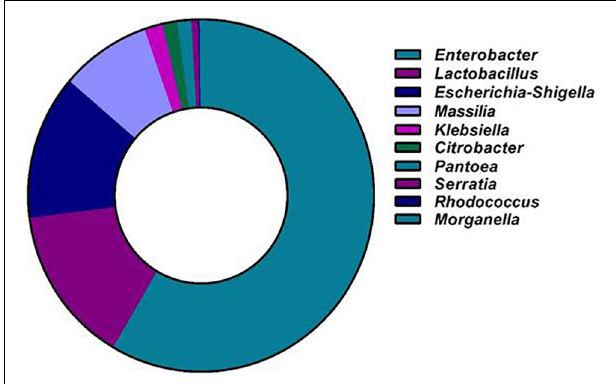
FIGURE 4 | Next-generation sequencing of culture-independent gut bacterial flora of A. florea . Genus level distribution of A. florea gut bacterial